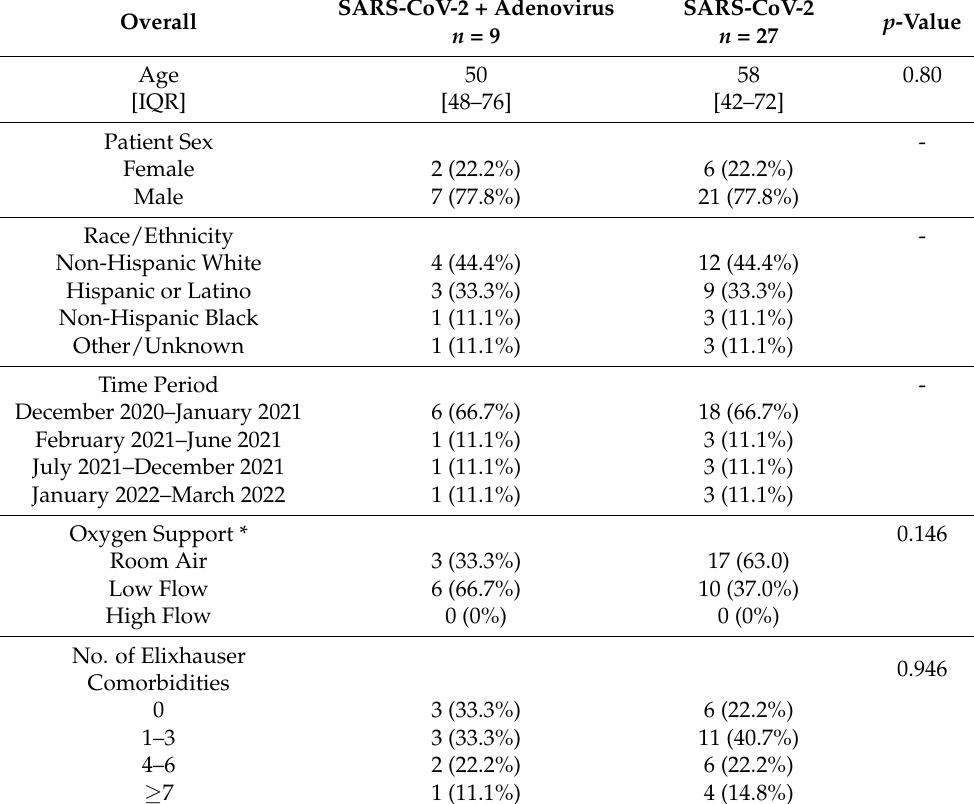
Table 2. Matched cohort of adults with SARS-CoV-2 + adenovirus infection or SAR-CoV-2